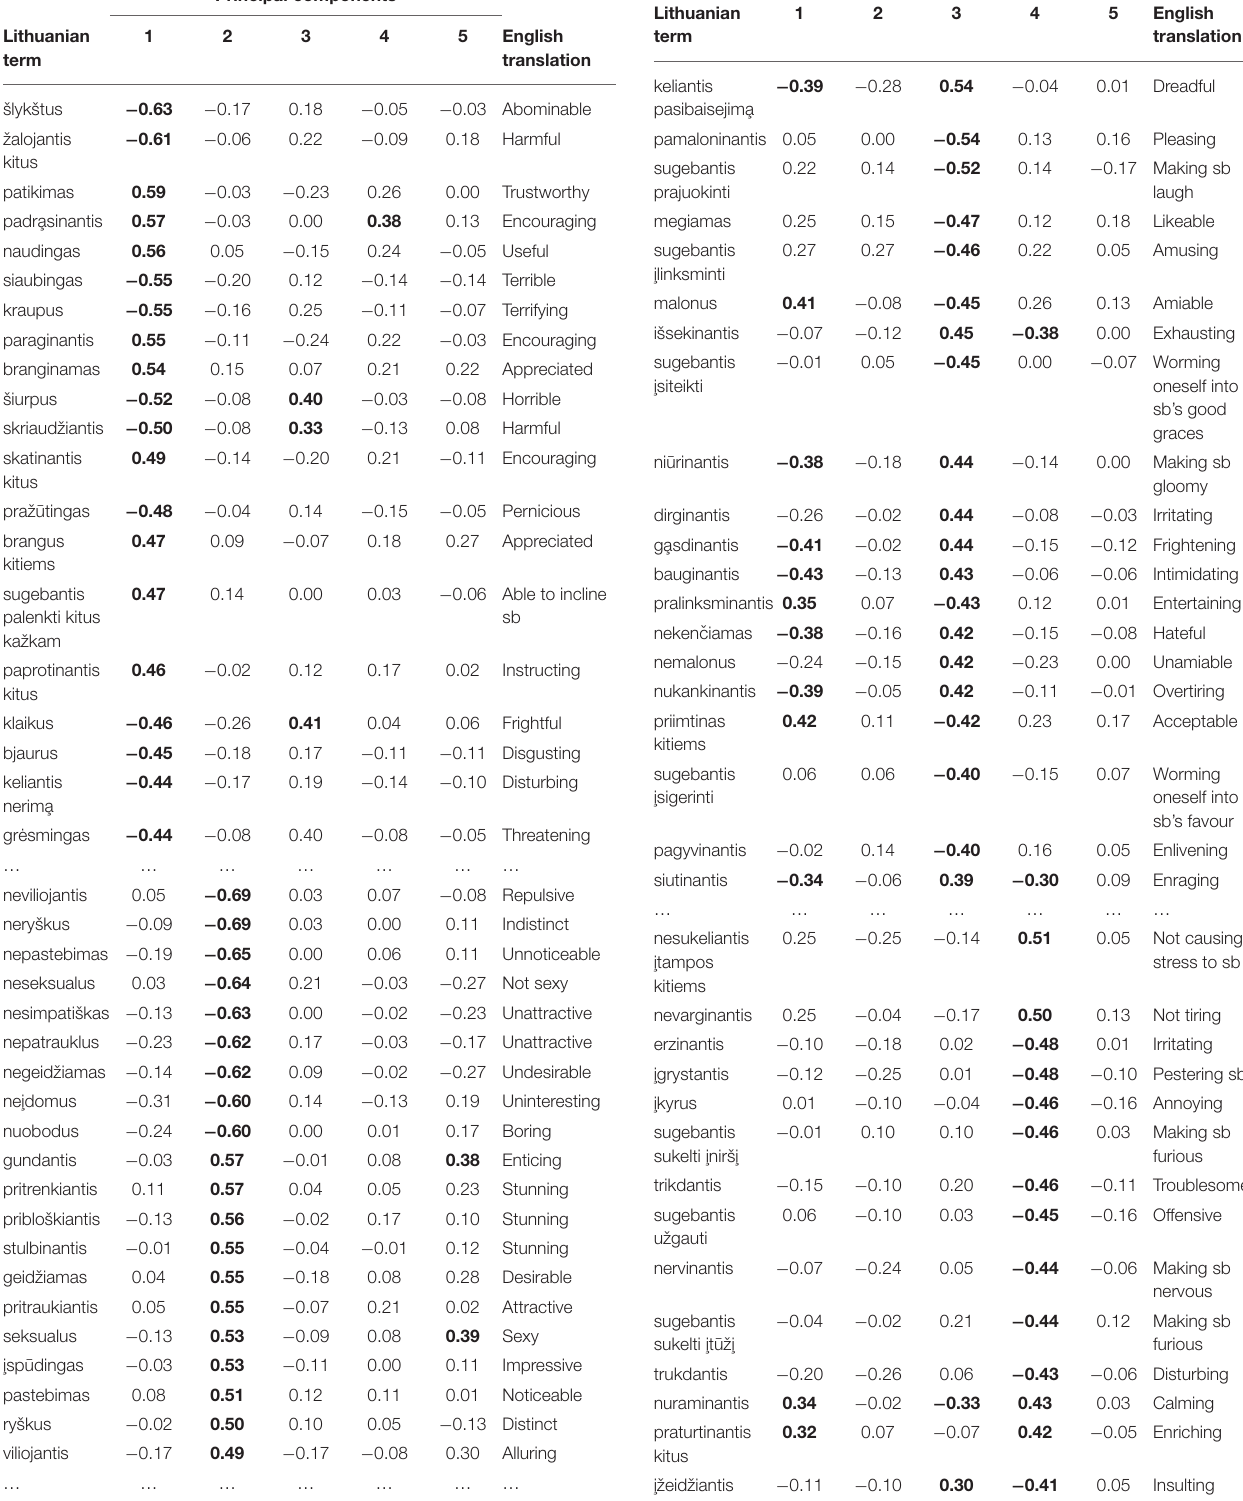
TABLE 6 | Varimax-rotated five-factor structure of the social effects in the self-rating data (20 highest loading terms for each dimension). Principal